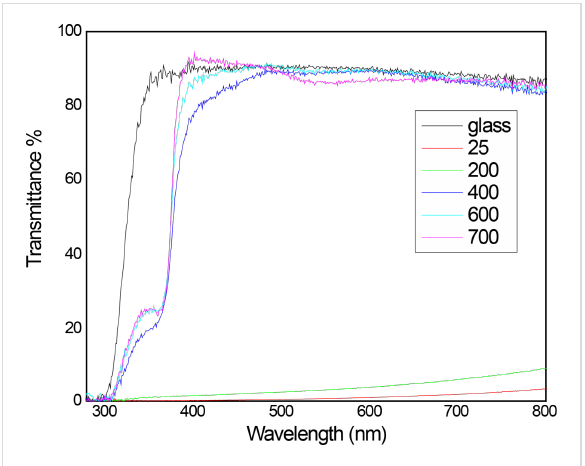
Figure 4: UV–vis spectra of ZnO thin films at different temperatures.